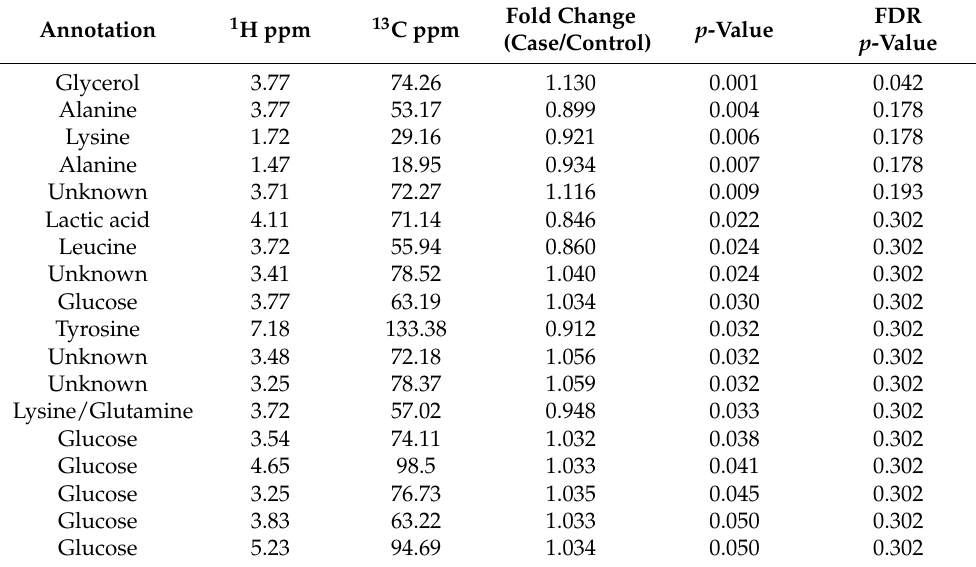
Table 2. Top significantly different 1 H- 13 C HSQC metabolite resonances ( p -value < 0.05) between male LRRK2 PD and